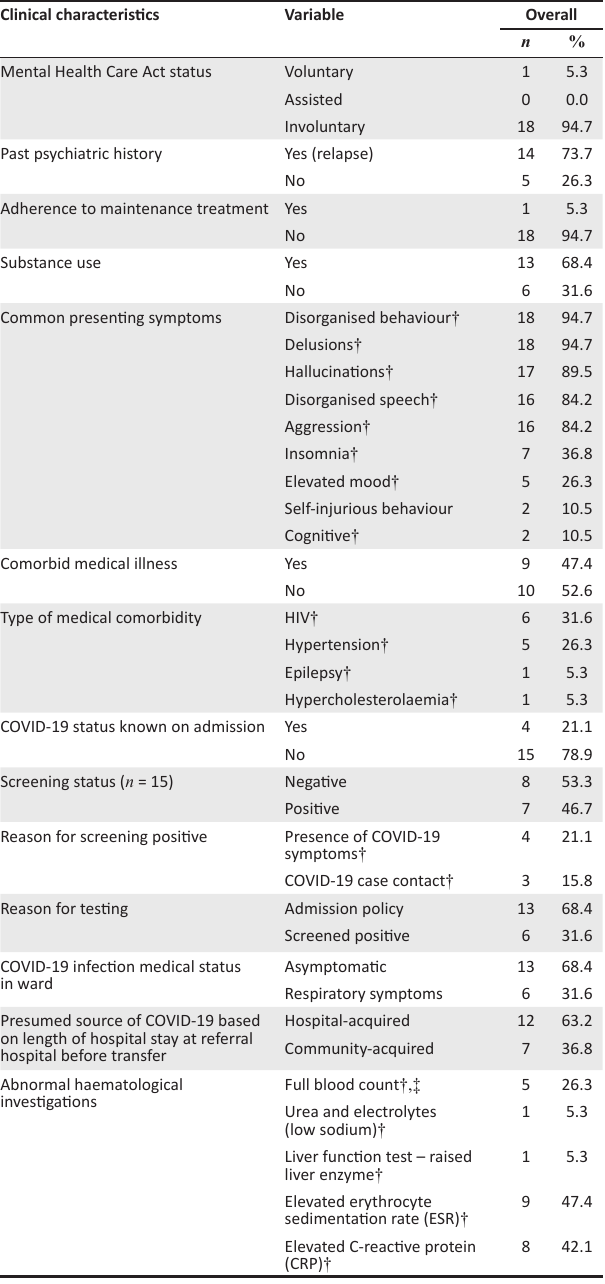
TABLE 2: Clinical characteristics of mental health care users testing COVID-19 reverse transcription polymerase chain reaction positive ( N = 19). Clinical